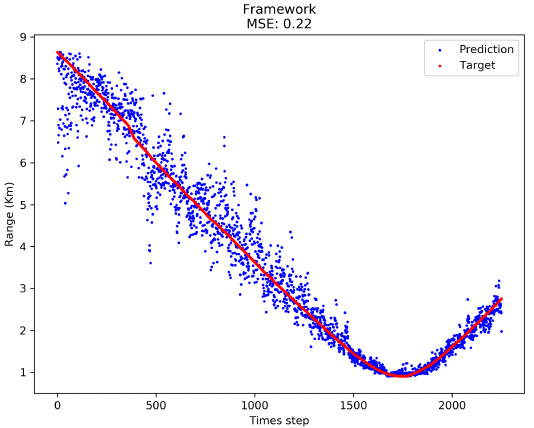
Figure 4. Illustration of the localization